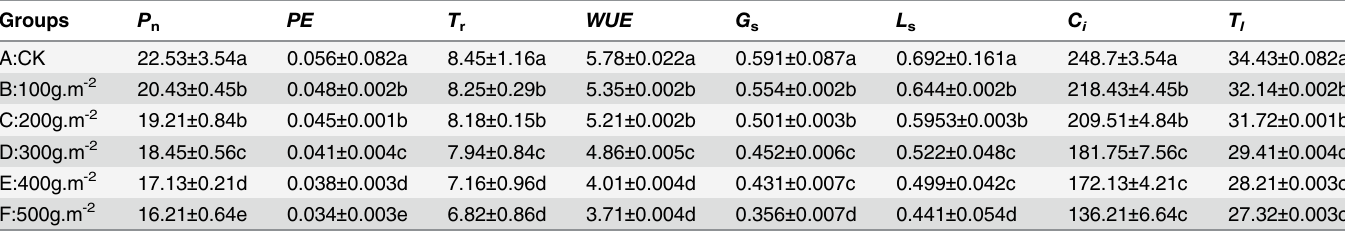
Samples within one index with different lowercase letters a, b, c, d and e had signi fi cant differences between different salt dust treatment groups( P < 0.05), while samples with matching lowercase letters had no signi fi cant